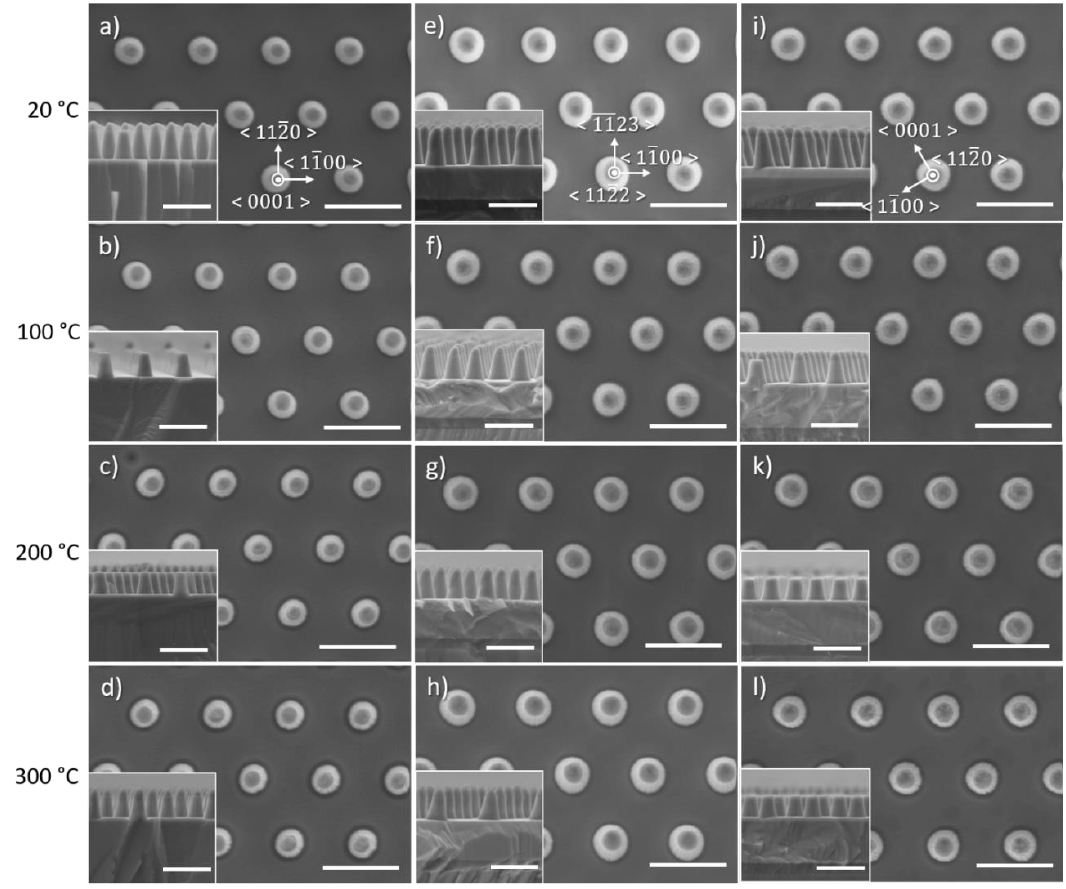
Figure 7. Plan view and cross-sectional (inset) SEM image of GaN nanorod etch series 4 under different chamber temperatures for ( a – d ) c -plane ( e – h ) (11 2̅2 ) semi-polar and ( i – l ) (11 2̅0 ) non-polar GaN layers. Scale bar is 1 µm.